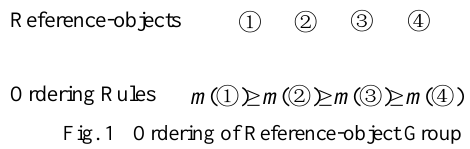
Fig. 1 Ordering of Reference-object Group The sorting operation is applied to the reference- object group only, and the rules of sorting is illustrated in Figure 1, where ( ) m  represent quality of an object, and objects are sorted in a proper sequence by their values of qualities. The other part of population, i.e. the floating-object group, does not need to be sorted, and the only requirement we need to ensure is that any floating-object’s fitness value should never be better than the worst